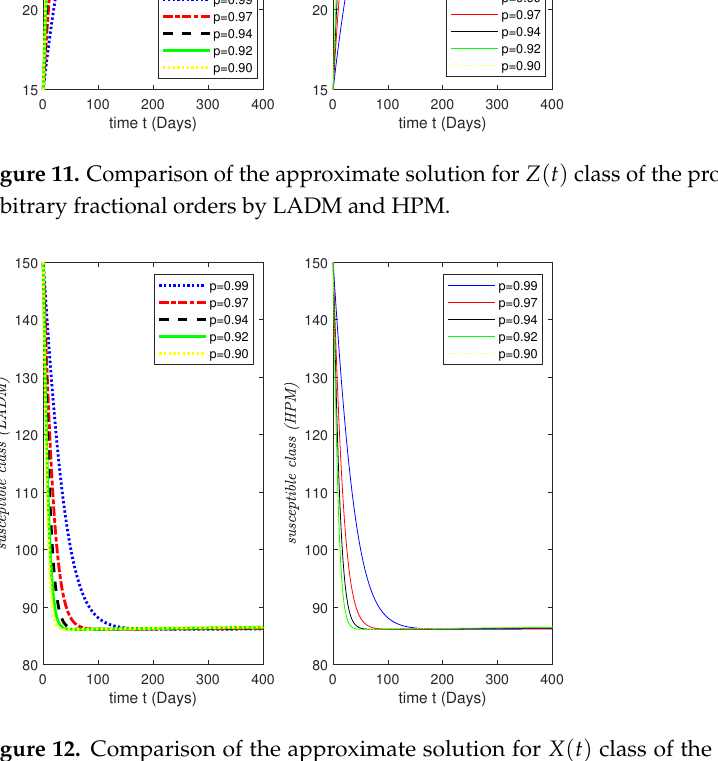
Figure 12. Comparison of the approximate solution for X ( t ) class of the proposed model having initial condition